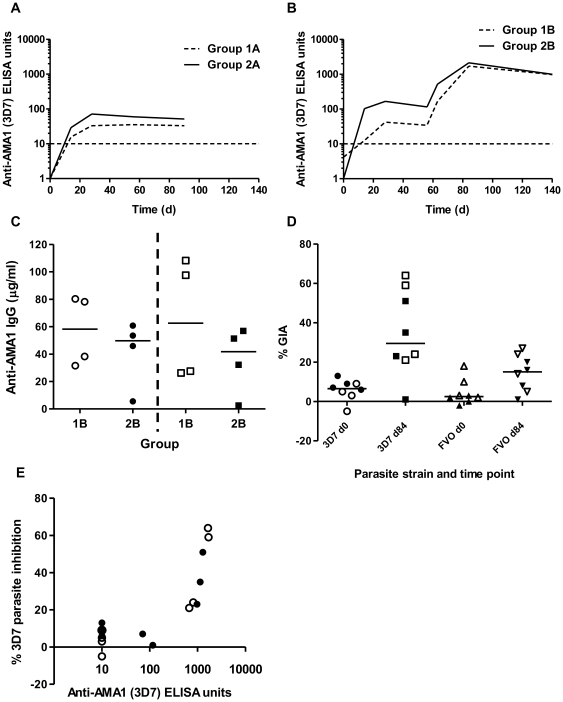
Antibody immunogenicity of ChAd63 AMA1 and ChAd63-MVA AMA1 immunization regimes.(A) Groups 1A and 2A and (B) groups 1B and 2B total IgG ELISA responses against 3D7 AMA1 as measured in the serum over time. The geometric mean response is shown for each group and individual responses are shown in Figure S7. The horizontal dotted line indicates the limit of detection of the assay. (C) AMA1-specific ELISA titers against 3D7 (circles) and FVO (squares) in µg/mL for group 1B (n = 4) and group 2B (n = 4) at the peak time-point (day 84). Individual data points and the median are shown. (D) % GIA against 3D7 and FVO parasites at day 0 and day 84 in group 1B (open symbols) and 2B (closed symbols). (E) Relationship between 3D7 strain % GIA and serum 3D7 AMA1-specific IgG ELISA titer at day 0 and day 84 in groups 1B (open symbols) and 2B (closed symbols).